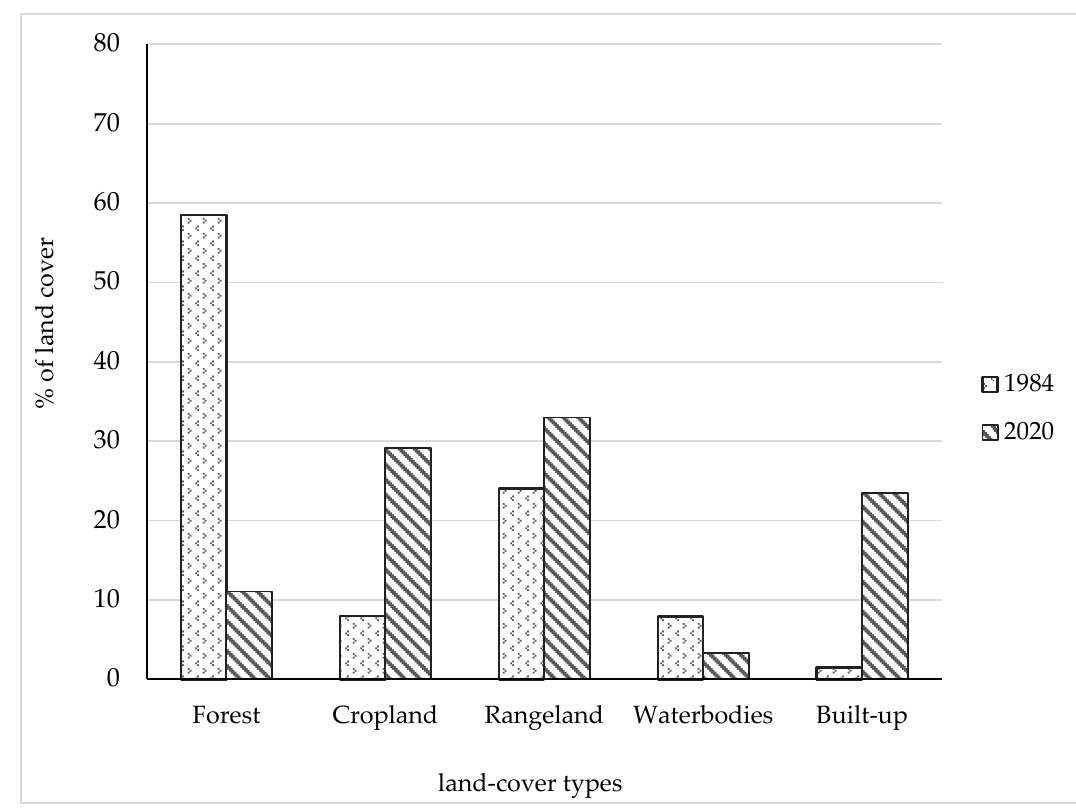
Figure 2. Land-cover types in 1984 and 2020 in the Chief Chikanta(cid:31)s area where the two villages are located.